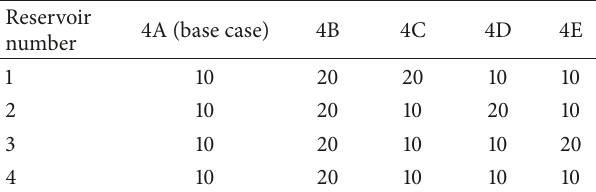
Table 8: Five cases with different reservoir logging porosities